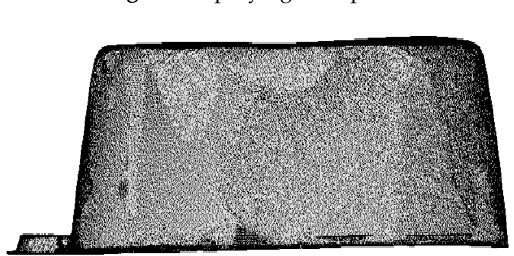
Electronics 2019 , 8, x FOR PEER REVIEW